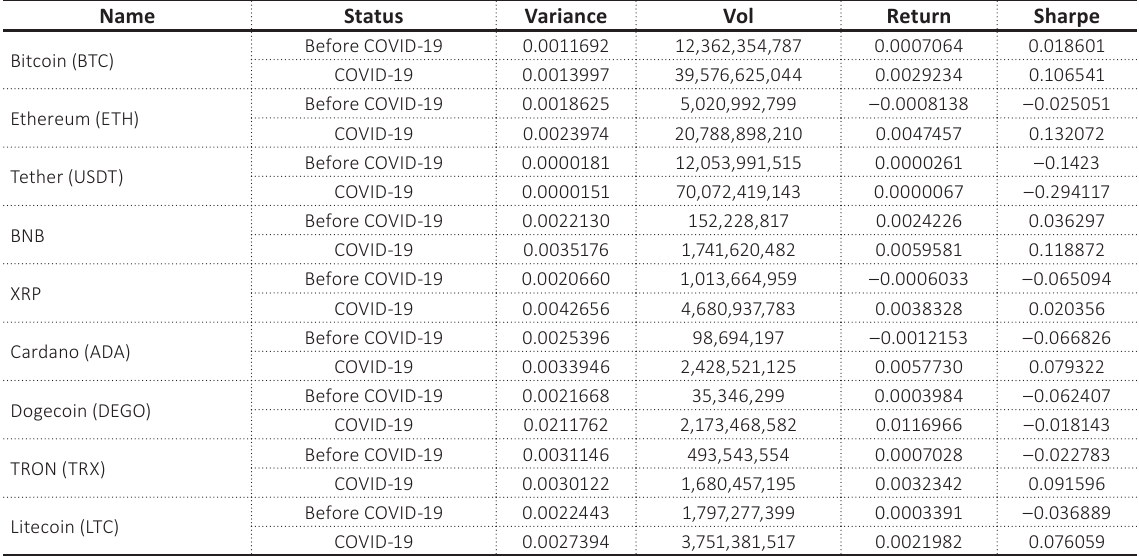
Source: Data processed.